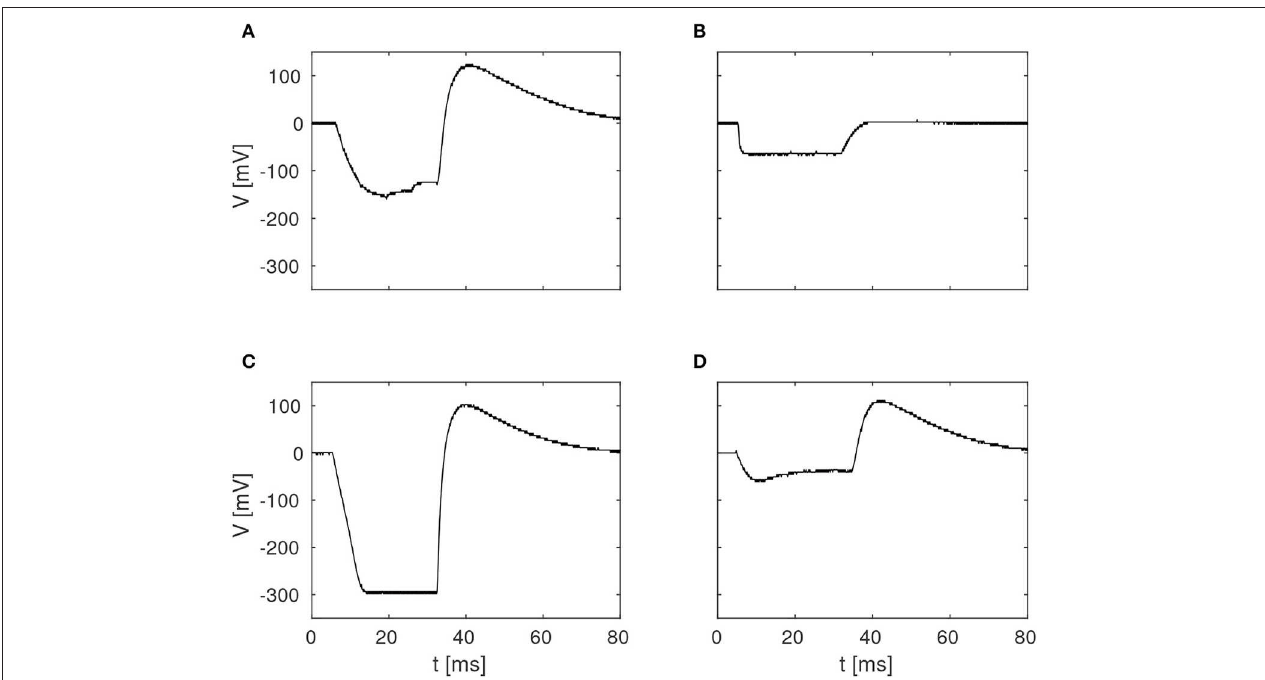
FIGURE 4 | Examples of four different membrane potentials measured in the characterization of the delay elements summarized in Figure 3 . These variations were observed in one core with 256 neurons, with biases configured according to Table 1 .